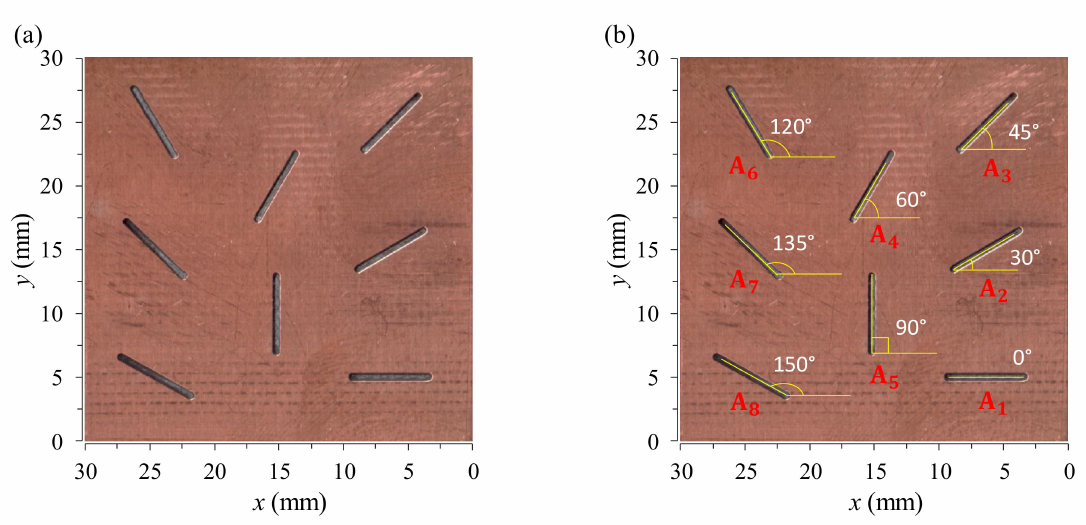
Figure 6. An aluminum plate with long machined cracks of different depths. ( a ) Photograph of aluminum sample. ( b ) Surface flaws. ( c ) Subsurface flaws with an aluminum tape layer attached. ( d ) Subsurface flaws with three aluminum tape layers attached.